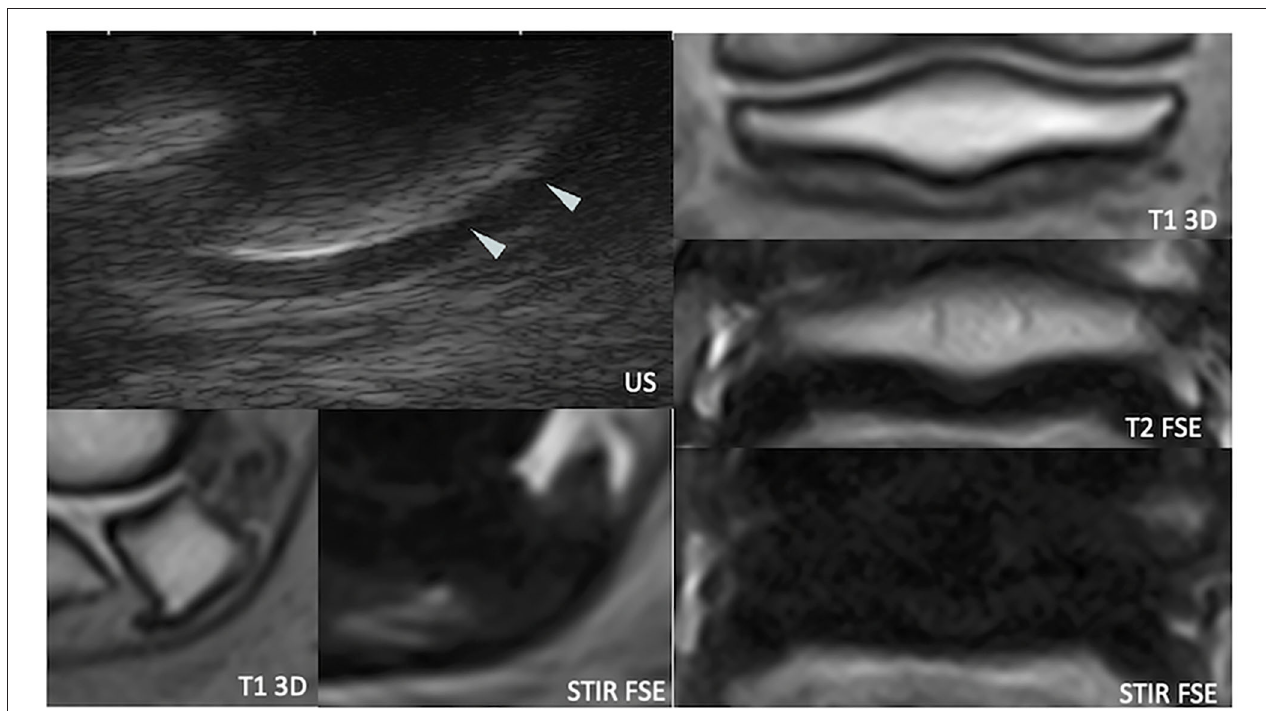
FIGURE 6 | Longitudinal transcuneal ultrasonographic (top left), sagittal (bottom left), and transverse (right) magnetic resonance (MR) images of a right front foot, focused on the navicular bone. The ultrasonographic image has been flipped vertically to obtain the same orientation than the MR images. The mid-sagittal fossa of the palmar navicular compact bone shows sharp ultrasonographic margins (arrowheads). US, ultrasonography; T1 3D, tridimensional gradient echo T1 weighted sequence; T2 FSE, fast spin echo T2 weighted sequence; STIR FSE, fast spin echo short tau inversion recovery weighted sequence.